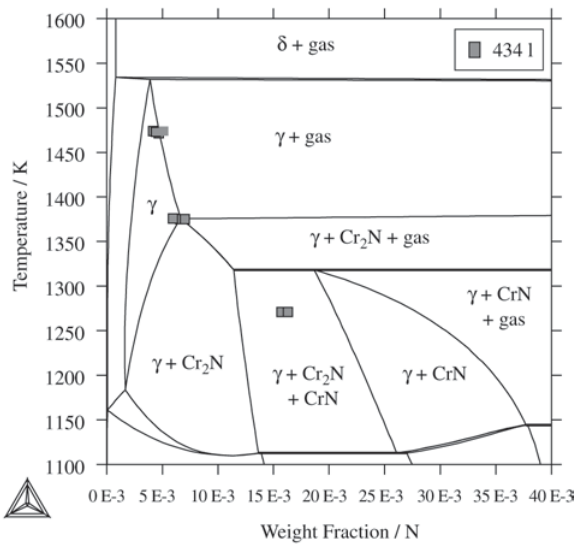
Figure 6. Isopleth of the Fe-16.2% Cr-N phase diagram and 0.25 MPa N pressure. The nitrogen contents of the samples are 2 shown as small squares.